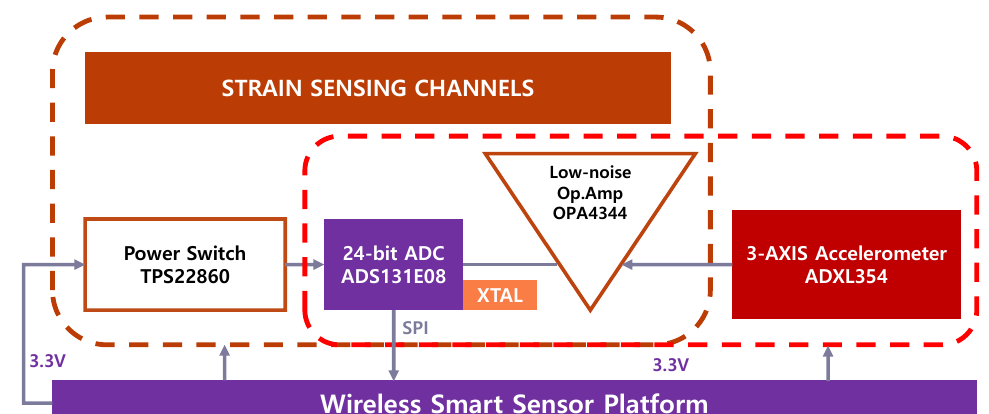
Figure 2. Configuration of the developed multimetric board.